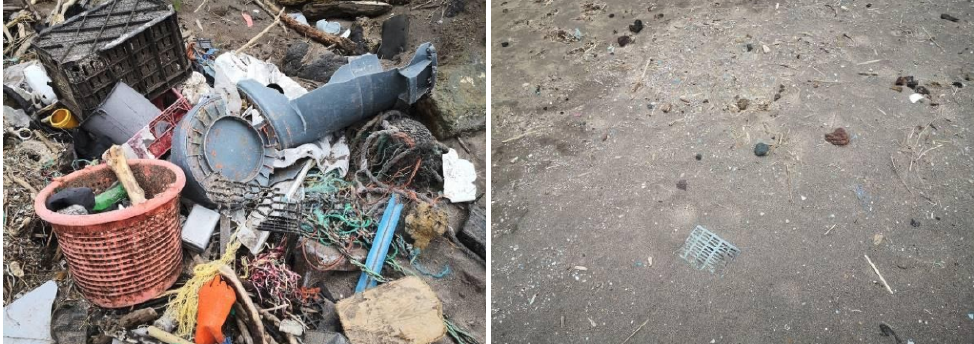
Figure 2. Marine Litter found in the test site, Porto Pim Bay (Faial Island,